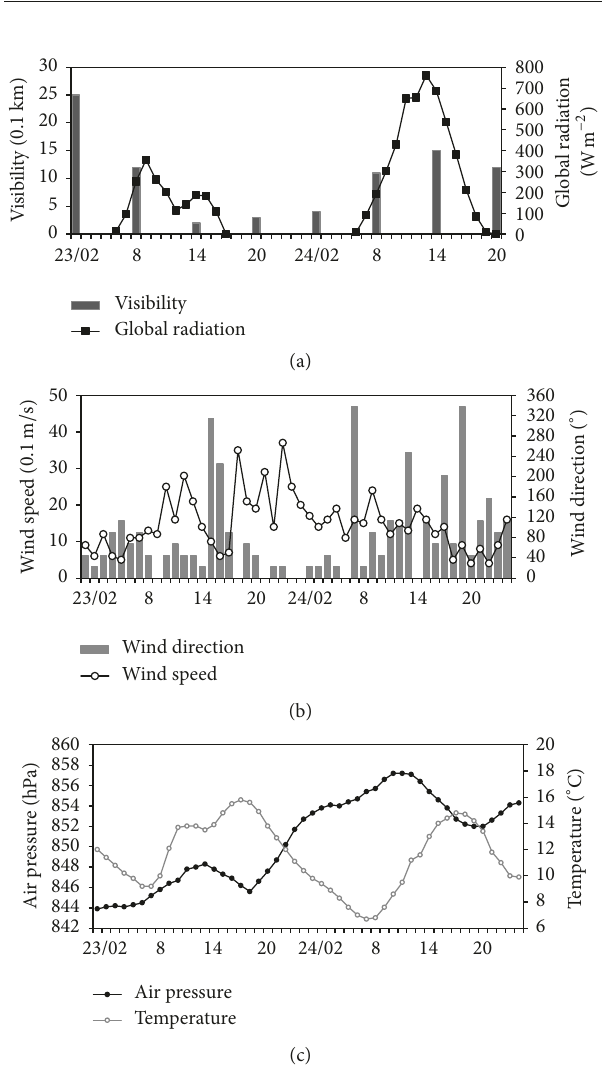
Figure 3: Evolution of the observational elements from April 23 to 24, 2009 (BJT). (a) 6-hour visibility and irradiance; (b) hourly wind speed and wind direction; (c) air pressure and temperature.